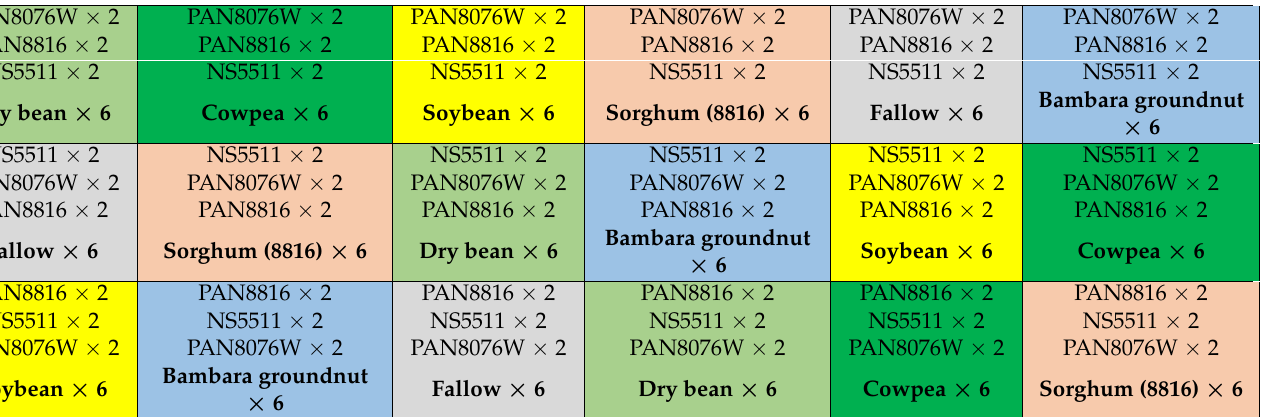
(Table 1). All three sorghum cultivars were planted in each sorghum treatment, with two rows per cultivar (total of six rows allocated for sorghum) randomized per treatment. Each treatment of sorghum was paired up with a treatment of legumes planted in the remaining rows. Standard agricultural practices and the maintenance of the trial were performed by the staff of the Agricultural Research Council. Table 1. Schematic representation of the field layout. PAN8706W, PAN8816, and N5511 are the sorghum cultivars used in this study. ‘ × 2 (cid:48) and ‘ × 6 (cid:48) depicts 2 and 6 rows of cultivated sorghum and leguminous plants, respectively. The similar color code indicates similar plant combinations with alternating